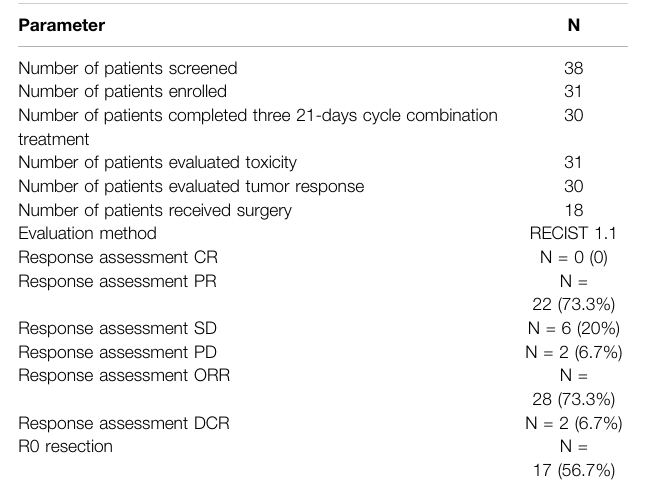
TABLE 3 | Primary assessment method: Overall assessment.